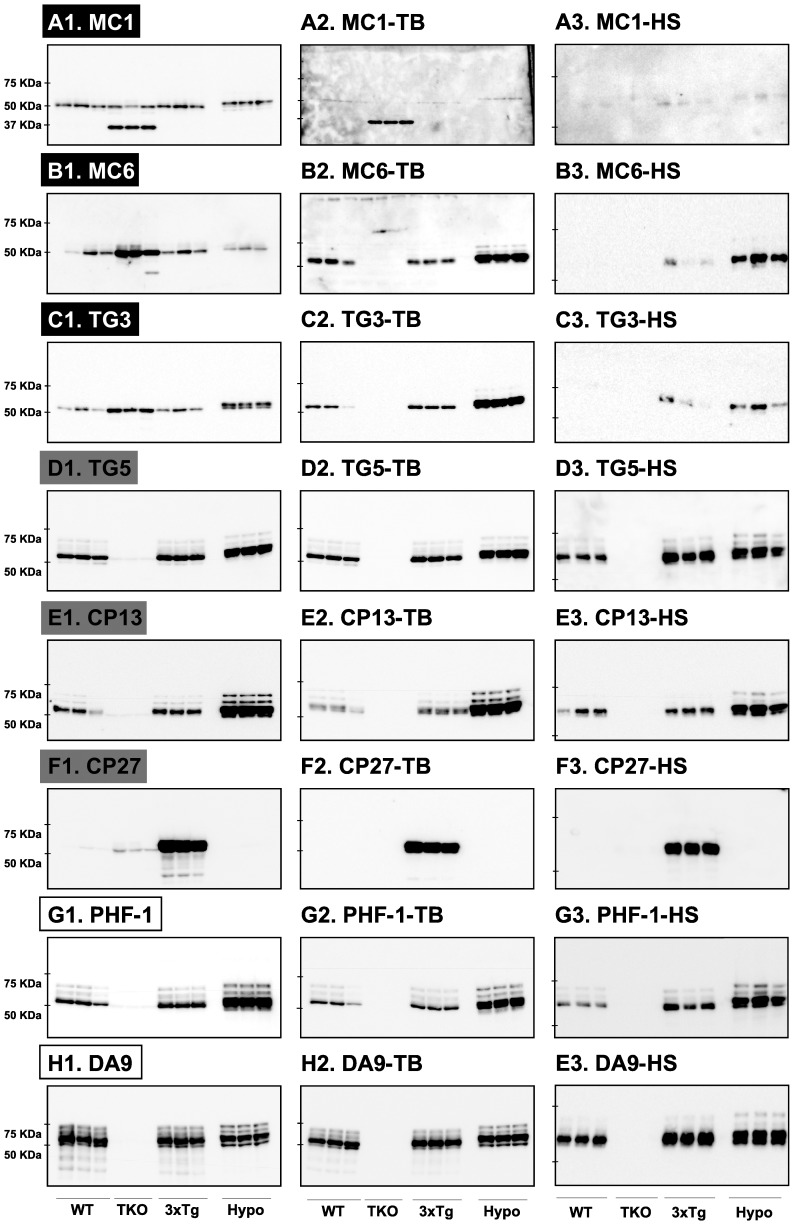
Analysis of tau signal with non-commercial monoclonal antibodies by Western blotting.The proteins were extracted form the cortex of 3 mouse lines: control mice (WT and Hypothermic), Tau KO mice and 3xTg mice with n = 3 for each group. Proteins were extracted with SDS-PAGE and then identified with the following commercial monoclonal antibodies: A: MC1, B: MC6, C: TG3, D: TG5, E: CP13, F: CP27, G: PHF-1, H: DA9. Normal anti-mouse (1) and Mouse TrueBlot ULTRA (2) secondary antibodies were used to detect primary antibodies. The heat stable fraction was used to remove non-specificity (3). Quantifications of the blots are available in Figure S2.